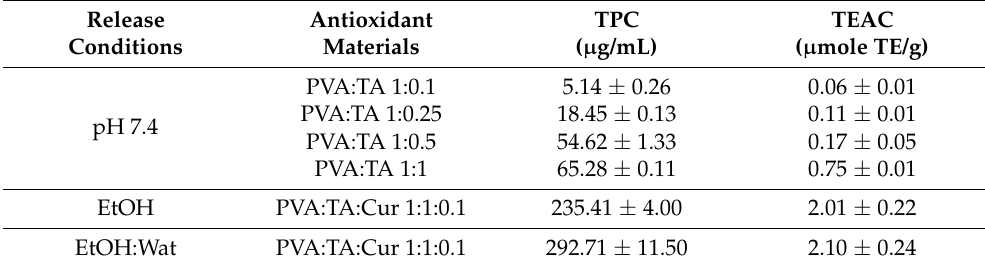
Table 2. Antioxidant activity of PVA:TA and PVA:TA:Cur cryogel composites; TPC value and